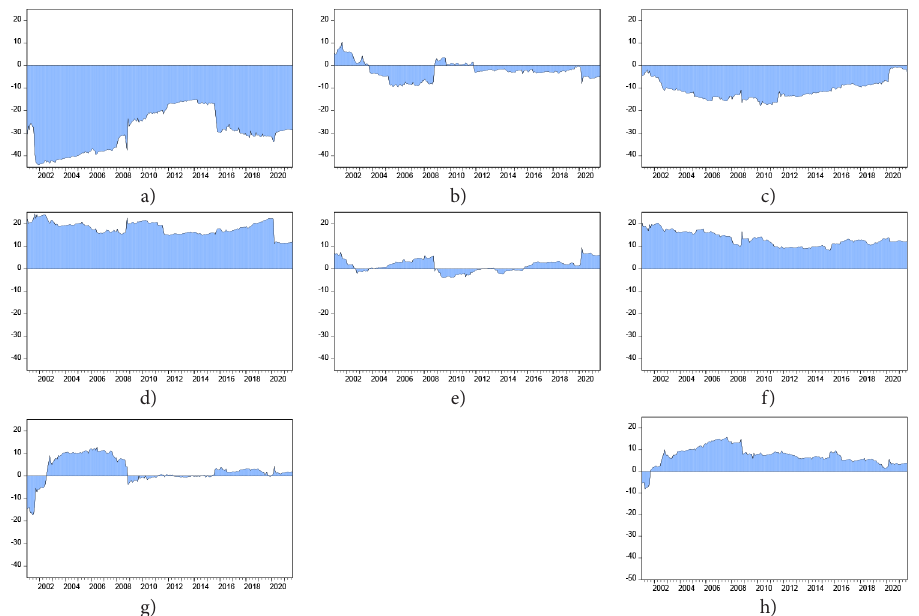
Figure 2. Dynamic Connectedness in the countries: a – Latvia; b – Lithuania; c – Estonia; d – Czech Republic; e – Poland; f – Hungary; g – Germany; h – France (source: results obtained by the